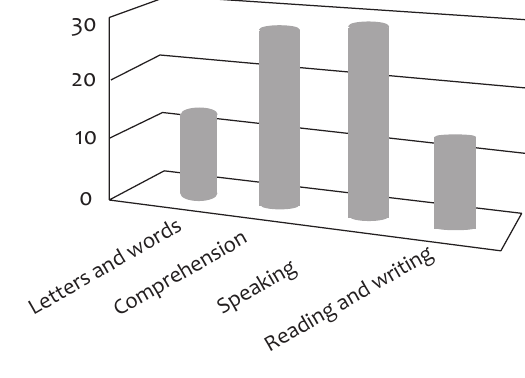
Figure 7: Question 4